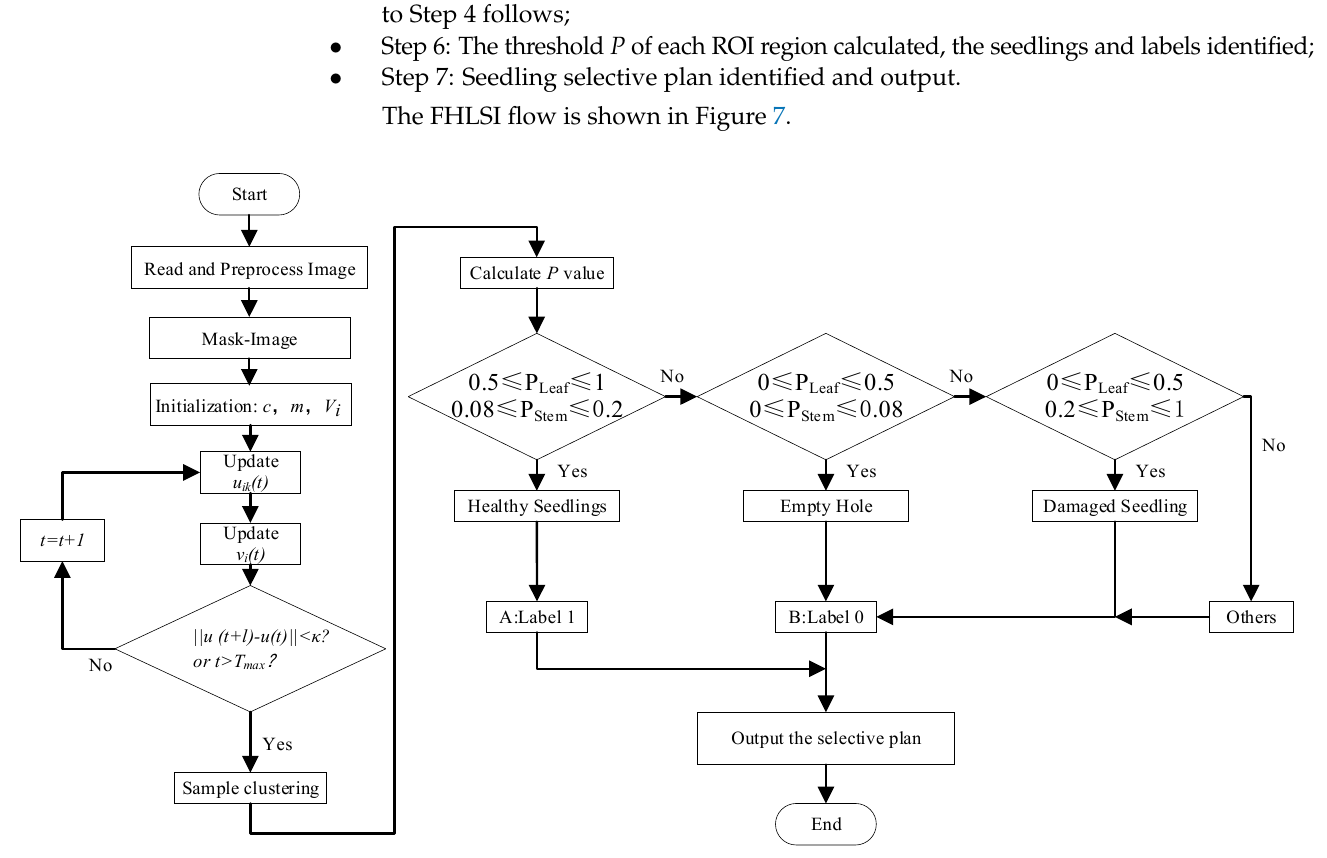
Figure 7. FHLSI flow. Note: κ is the iteration termination condition ( κ > 0); T max is the maximum number of iterations, t is the initial number of iterations.